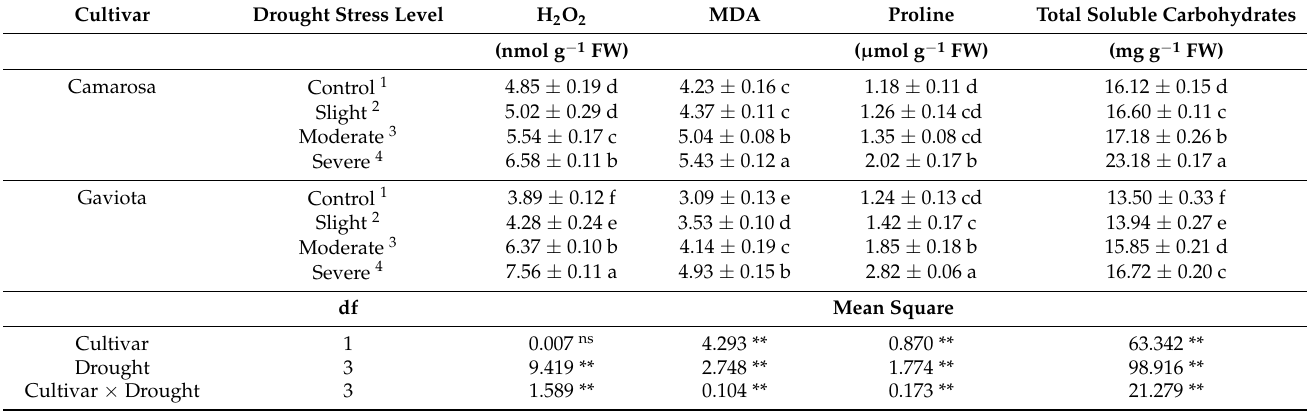
Table 3. Effects of different drought stress levels on oxidative markers [hydrogen peroxide (H 2 O 2 ) and malondialdehyde (MDA)] and osmolytes (proline and total soluble carbohydrates) in two strawberry